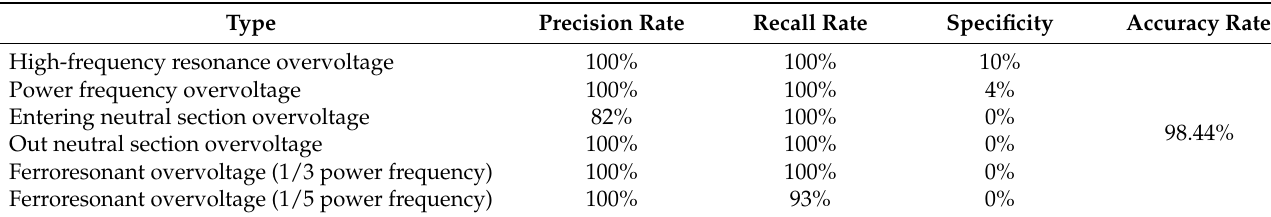
Table 2. Confusion matrix classification index.